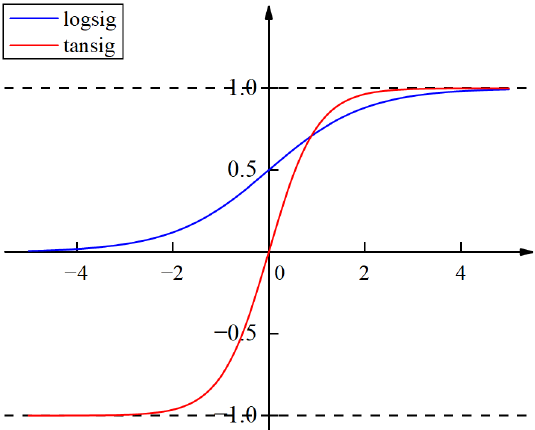
Figure 12. Nonlinear activation function.